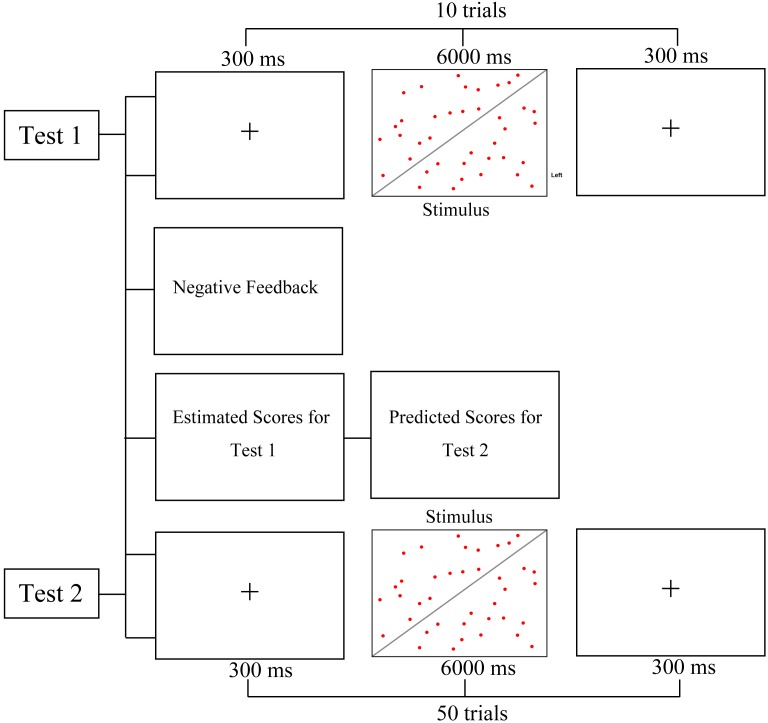
Procedure of Experiment 2.